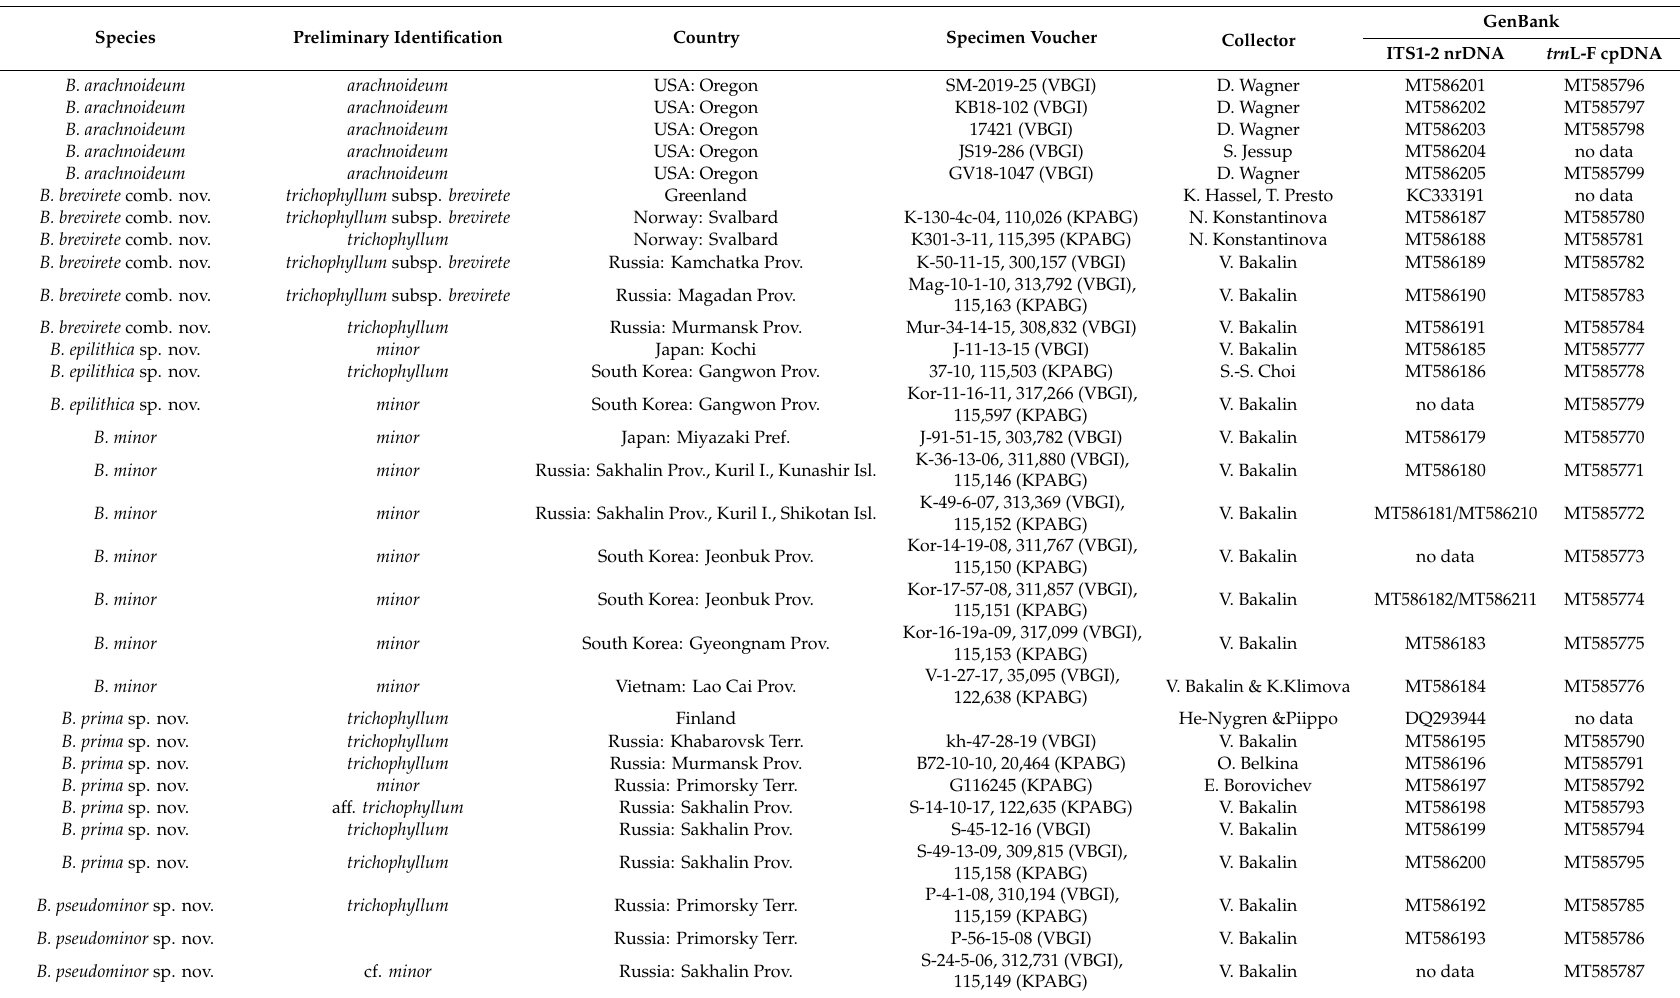
Table 1. The list of taxa with notes on preliminary identifications, specimen vouchers, and GenBank accession numbers. Accession starts from MT were sequenced in the current